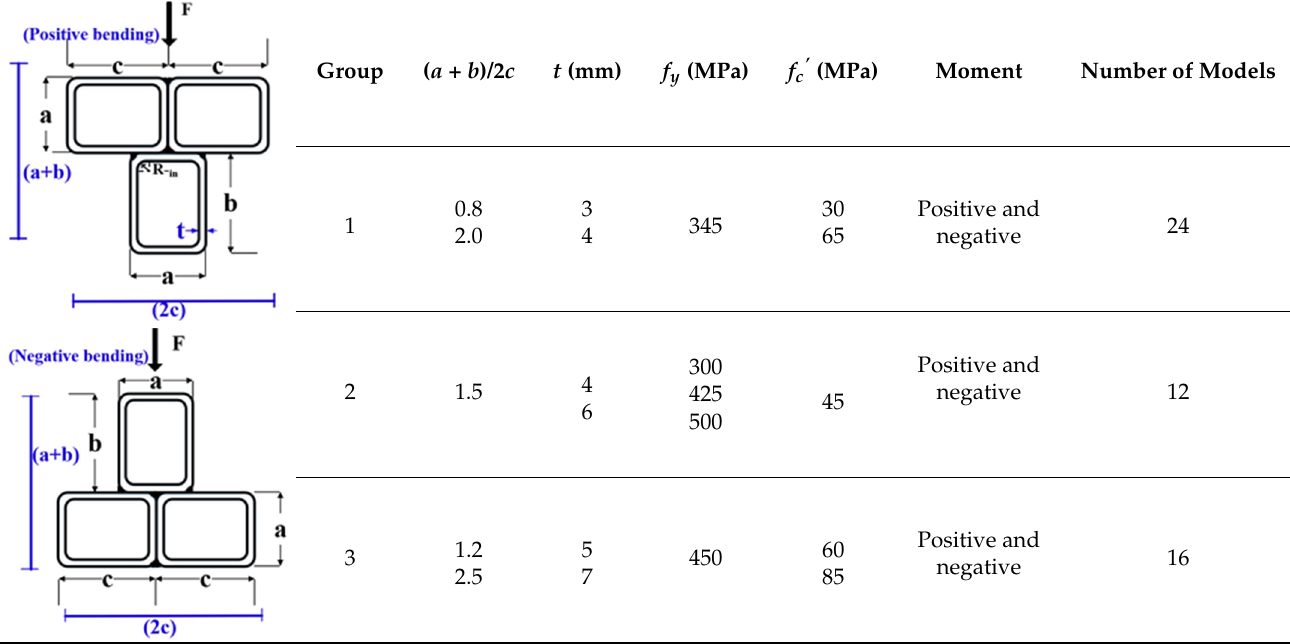
Figure 14. Comparison of predicted results (from PSDM and Unified Theory) against numerical results.